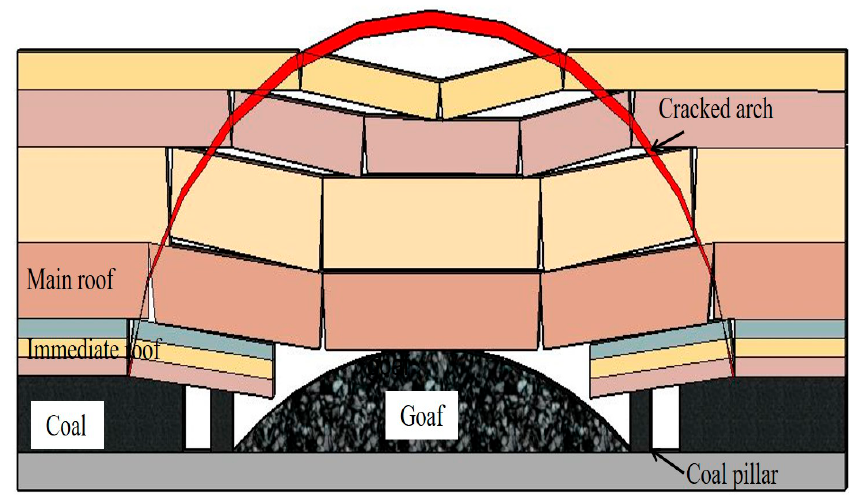
Figure 18. Overburden movement status in traditional coal pillar mining.